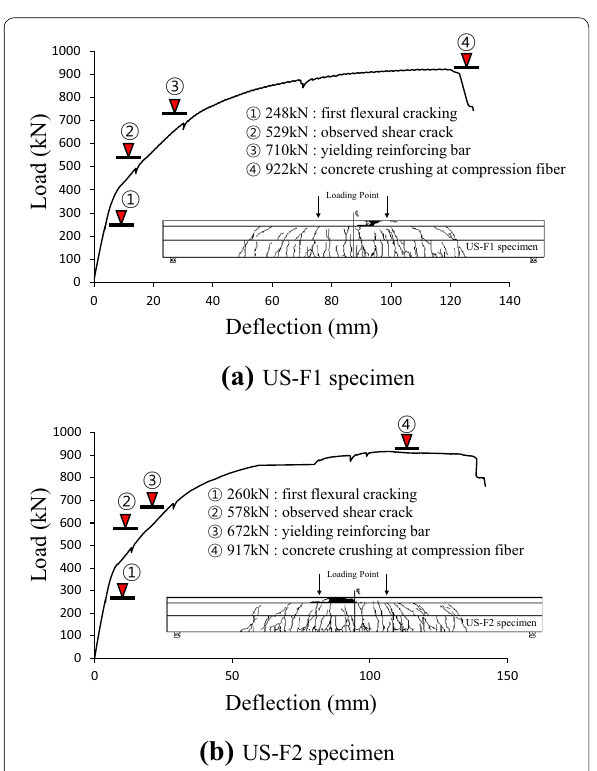
Fig. 8 Load‑deflection response curves of test